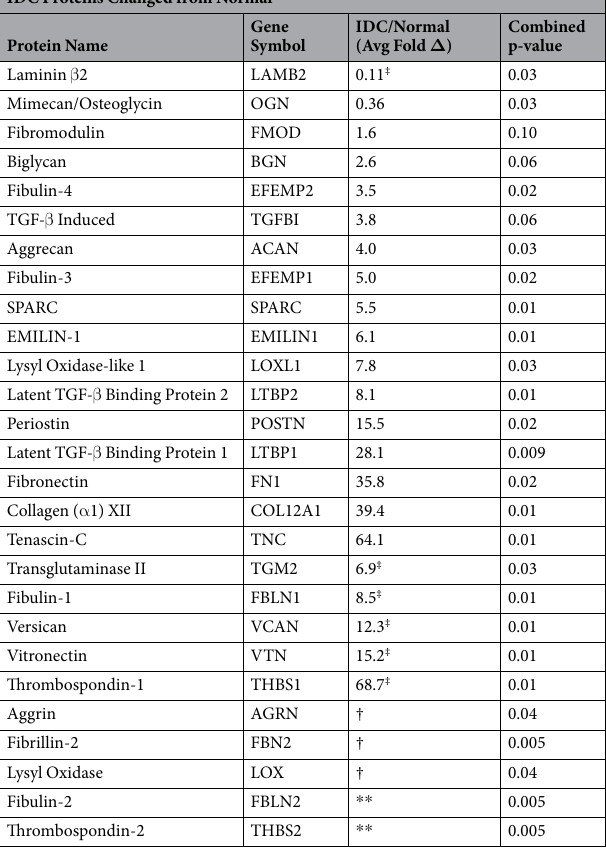
Table 1. List of twenty-seven significantly changed, and trending, ECM proteins between normal breast and IDC-s samples with aligned collagen. Twenty-seven significantly changed ECM proteins between normal breast and IDC tissues. The upper two rows indicate the consistently down-regulated proteins in IDC compared to the normal tissues. The other rows indicate consistently up-related proteins in IDC compared to the normal tissues. ‡ Protein recovered in both proteomic experiments (infinite relative fold change due to non-detectable recovery in normal tissue of one of the experiments). † Protein recovered only in the targeted proteomic analysis (infinite relative fold change due to non-detectable recover in normal tissue. ** Protein recovered in both proteomic experiments (infinite relative fold change due to non-detectable recovery in normal tissue samples for both